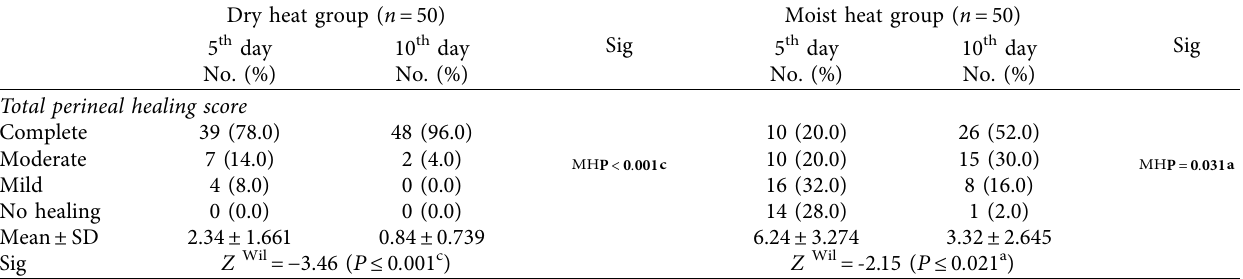
Table 4: Total scores of perineal healing on the 5 th and 10 th days after intervention among dry and moist heat groups. Dry heat group ( n � 50) Moist heat group ( n � Sig